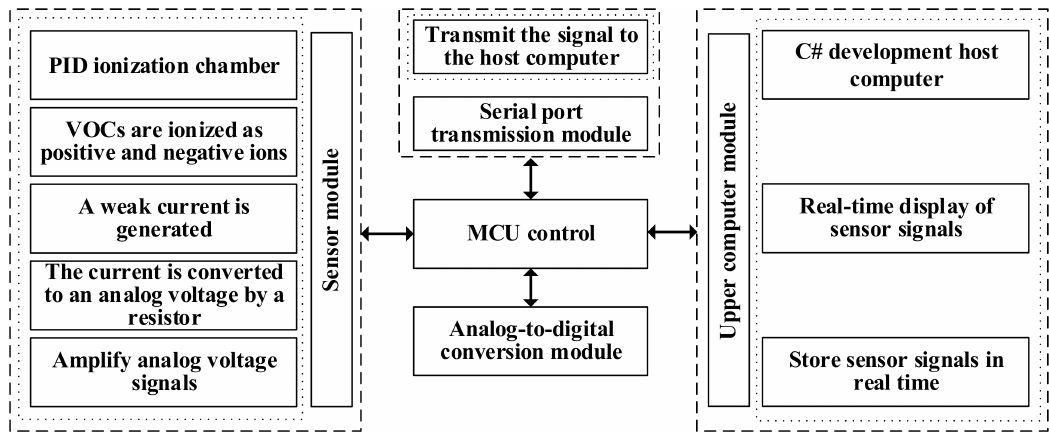
Figure 1. Composition of the VOC monitoring device.